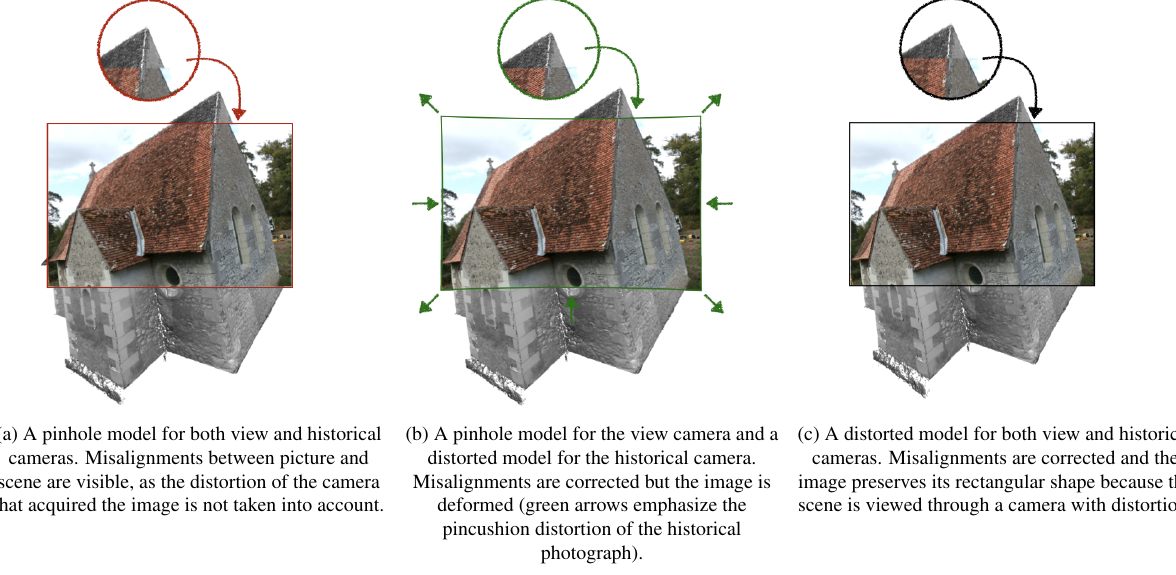
Figure 3. Comparison of projective texturing with different camera models for historical and view cameras.